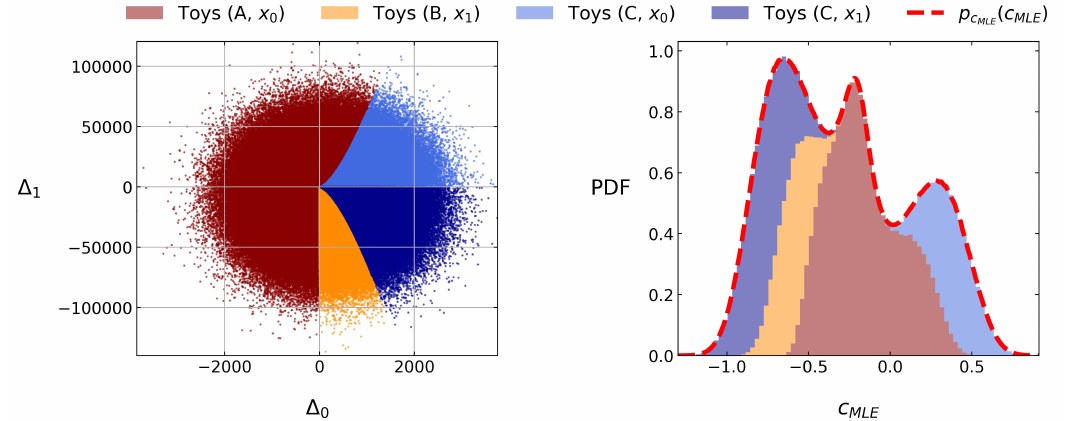
) -plane. Right: stacked distribution , ∆ 0 1 along with the modelled MLE